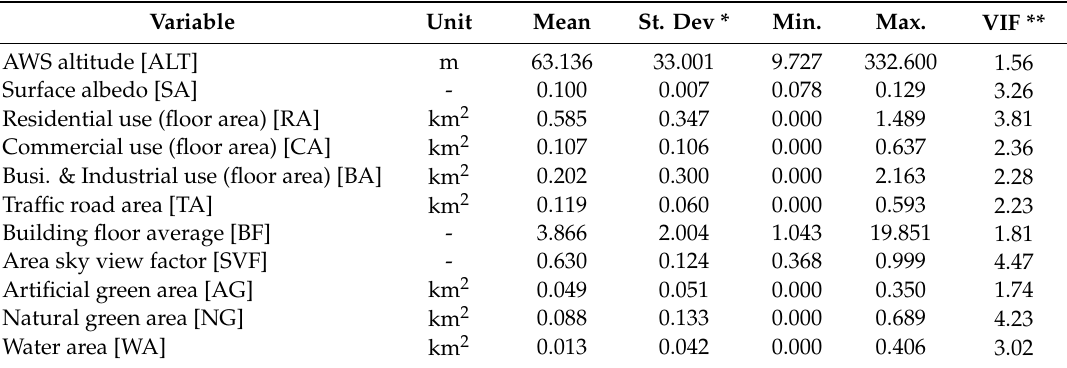
Table 1. Descriptive statistics.